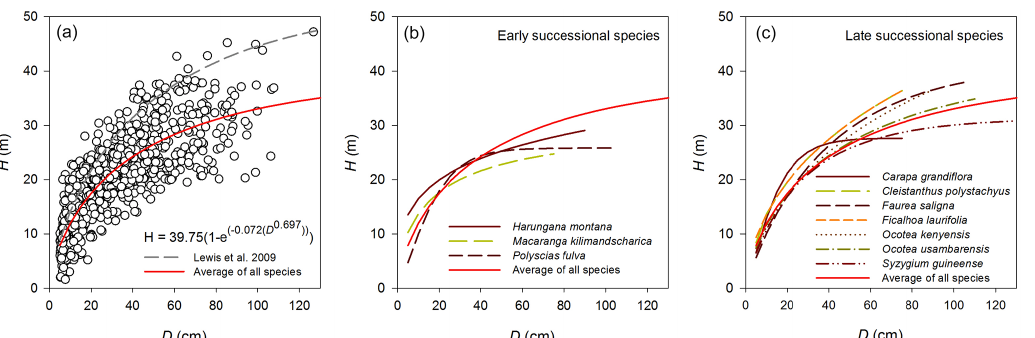
Figure 3. Height ( H) vs. stem diameter at breast height D relationship for 930 trees representing the 25 most abundant species of all plots and fitted to Eq. (2). The relationship for all measurements (red line) is compared to the measurements of 1982 trees in African tropical forests (Lewis et al 2009, grey dashed line) mainly at an altitude below 1000ma.s.l. (a) as well as to species-specific functions for the 10 most abundant species, including (b) three early successional species (ES) and (c) seven late successional species (LS). All species-specific data are presented in Table S3. The mean simulated height (m) at D = 10cm was 13.4 ± 3.3 in ES and 12.0 ± 1.4 in LS ( P = 0 . 35); D = 40cm was 23.3 ± 1.5 in ES and 25.9 ± 1.5 in LS ( P = 0 . 033); D = 80cm was 26.4 ± 1.7 in ES and 33.4 ± 3.9 in LS ( P = 0 . 020).